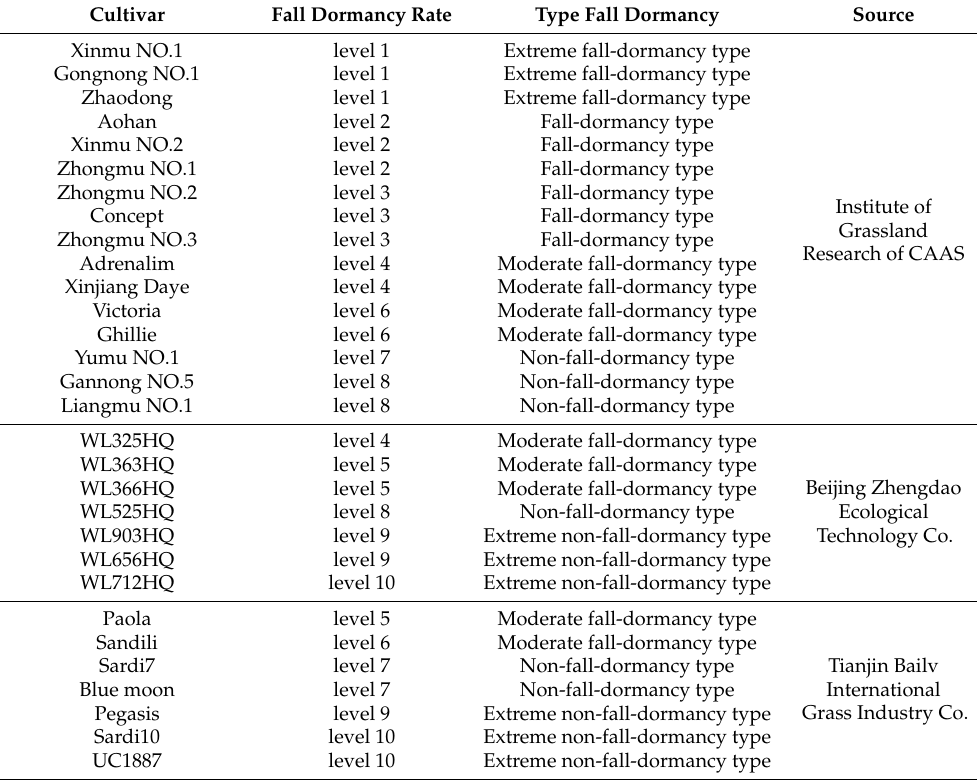
Table 1. Cultivars and sources of